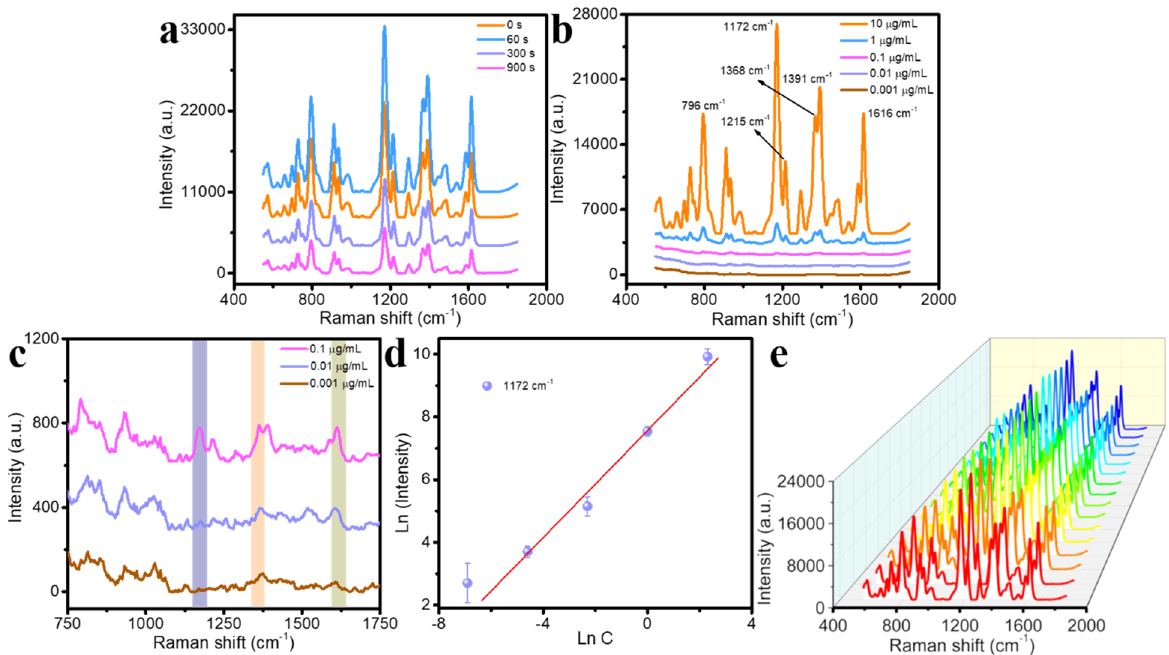
Figure 6. Raman spectra of the hydrophobic SERS substrates under the 785 nm wavelength. ( a ) Raman signals of the MG molecules with a concentration value of 10 µg/mL on the SERS substrates with different wettabilities. Raman performance of the MG molecules on the SERS substrates were immersed within NDM for 60 s: ( b ) concentration of the MG molecules from 1 ng/mL to 10 µg/mL, ( c ) magnified Raman spectra of the MG molecules from 1 ng/mL to 100 ng/mL, ( d ) the logarithmic function between Raman intensity of Raman band at 1172 cm − 1 and the MG concentration ranging from 1 ng/mL to 10 µg/mL, and ( e ) sixteen Raman spectra of the MG molecules with a concentration value of 10 µg/mL.